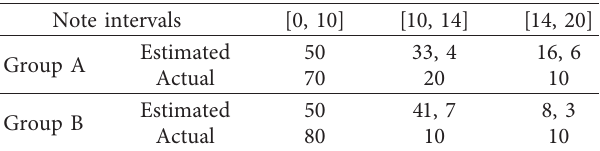
Table 4: Percentages of estimated and actual scores according to the two samples.